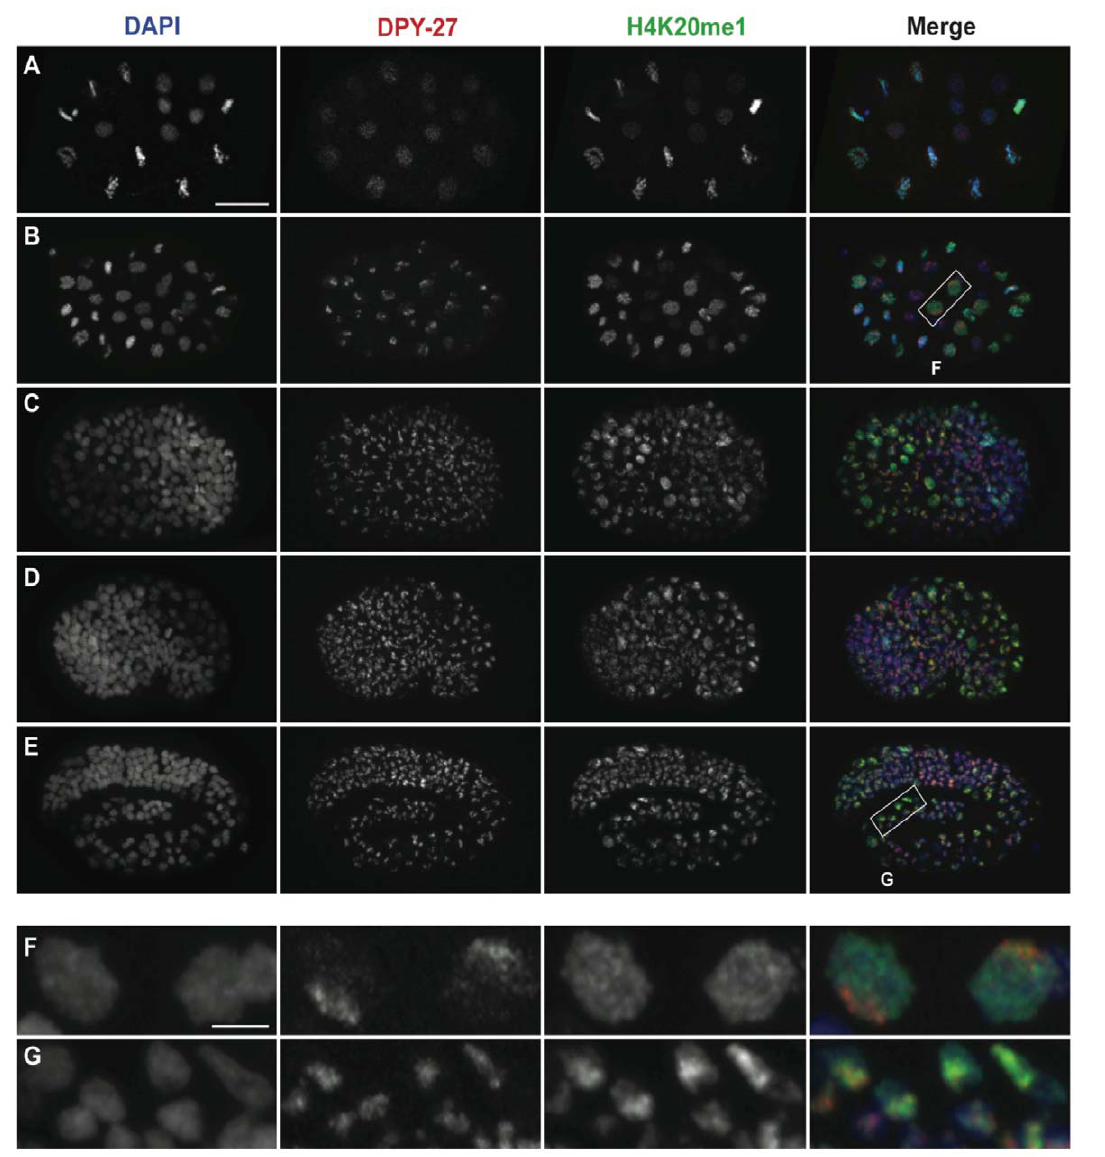
Figure 2. H4K20me1 becomes concentrated on the X chromosome after the DCC. Wild-type embryos at (A) 20-cell, (B) 40-cell, (C) bean, (D) comma, and (E) three-fold stages stained for DNA (DAPI, blue, left column), DPY-27 (red, second column), and H4K20me1 (green, third column). Boxed regions in B and E are enlarged in F and G, respectively. In very early embryos (A) DPY-27 exhibits weak and diffuse nuclear staining while H4K20me1 is diffuse in interphase nuclei and associated with condensed chromatin during mitosis. By the , 40-cell stage (B, F) DPY-27 is enriched on the X chromosome, while H4K20me1 continues to show a uniform nuclear distribution. Comma-stage embryos (D) contain some nuclei with H4K20me1 enrichment on the X. This enrichment becomes more apparent as embryogenesis progresses, and by the 3-fold stage (E, G) H4K20me1 is concentrated in bright foci that co-localize with DPY-27 on the X. Scale bars represent 10 um (A–E) and 2 um (F, G). Monoclonal antibody15F11 was used to detect